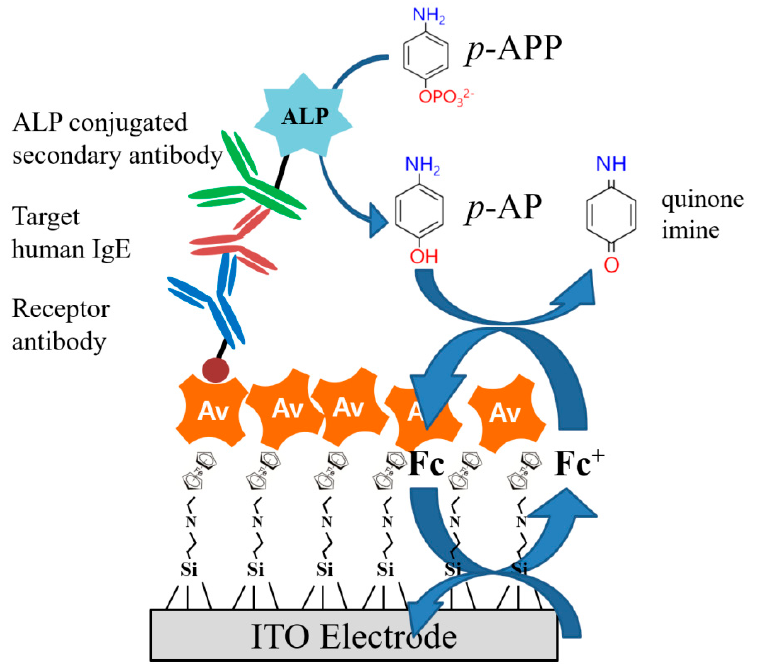
Scheme 2. Schematic illustration of an electrochemical amplification of the immunosensor using redox ‐ cycling.